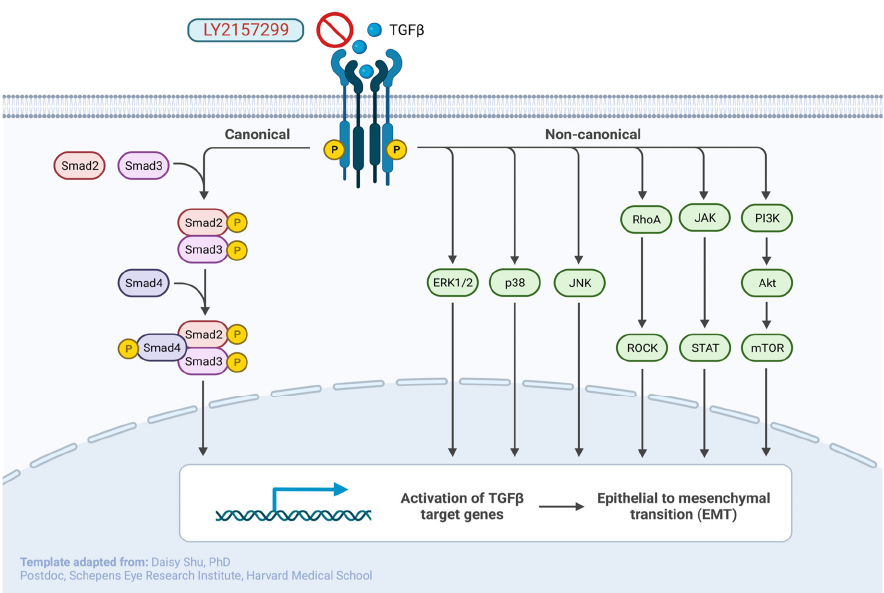
Figure 2. Mechanism of action of the TGF- β inhibitor LY2157299. As shown, inhibition of TGF- β causes downstream inhibition effects on SMAD, ERK1/2, p38, JNK, RhoA/ROCK, JAK/STAT, and PI3K/Akt/mTOR, leading to decreased activation of TGF- β target genes, and a decrease in EMT. Created with BioRender.com (accessed on 11 March 2023).